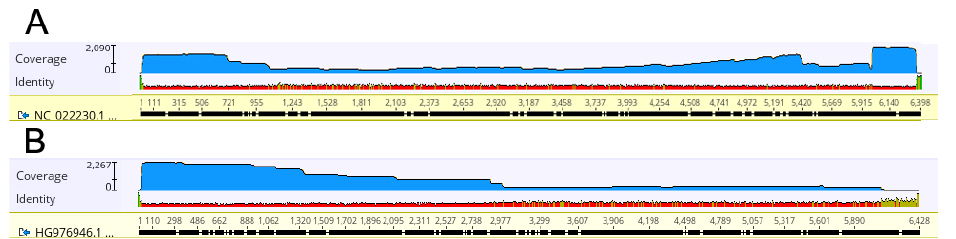
Figure 5. Coverage of MinION-derived reads aligned to the full-length sequences of ( A ) the ToMMV genome, and ( B ) the PepMV genome. The coverage of reads mapping along the two viral genomes is graphically represented by the blue areas. Vertical bars on the left indicate the maximum coverage of nucleotide positions expressed in X.